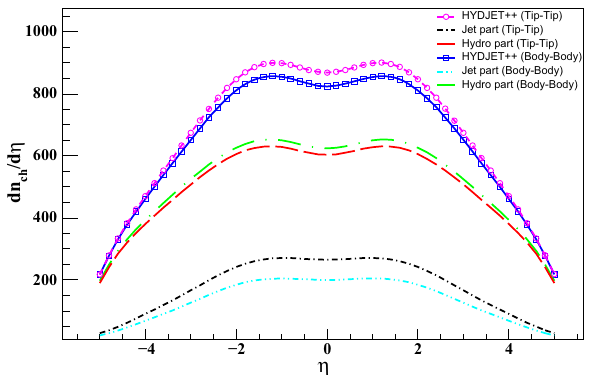
Fig. 11 Comparison of pseudorapidity distribution in tip–tip and body–body configuration for most central collisions